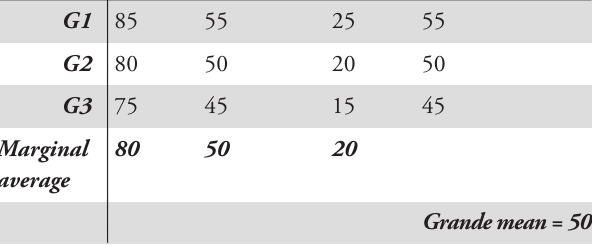
Table 1: Fictional data for plant heights and water-breed